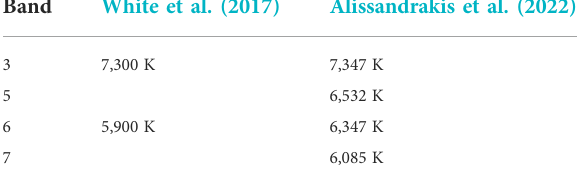
TABLE 3 Total power map